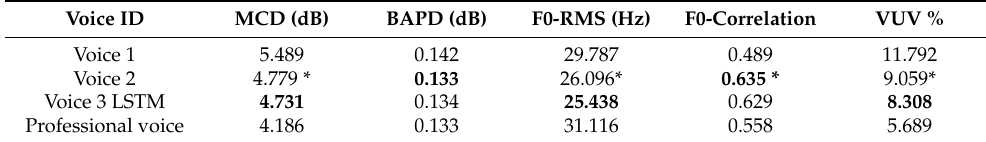
Table 2. Values of acoustic parameter errors calculated for verification